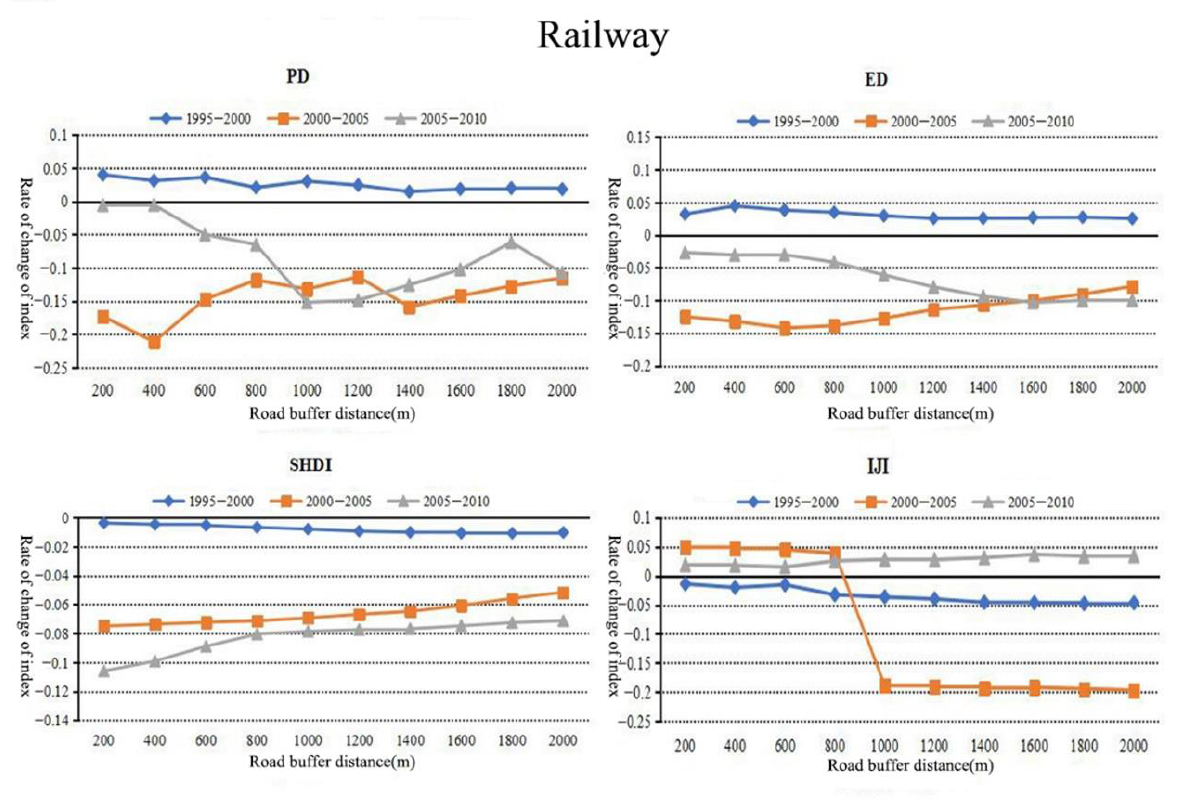
Figure 7. Graph of correlation between index change rate and buffer distance (railways).